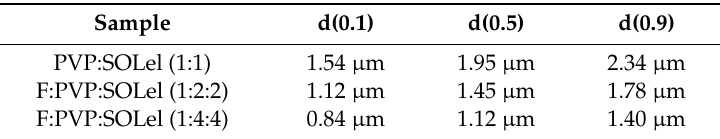
Table 2. Percentile values of the electrospun fiber diameters: d(0.1), d(0.5), and d(0.9) are the fractions of fibers with the reported size or